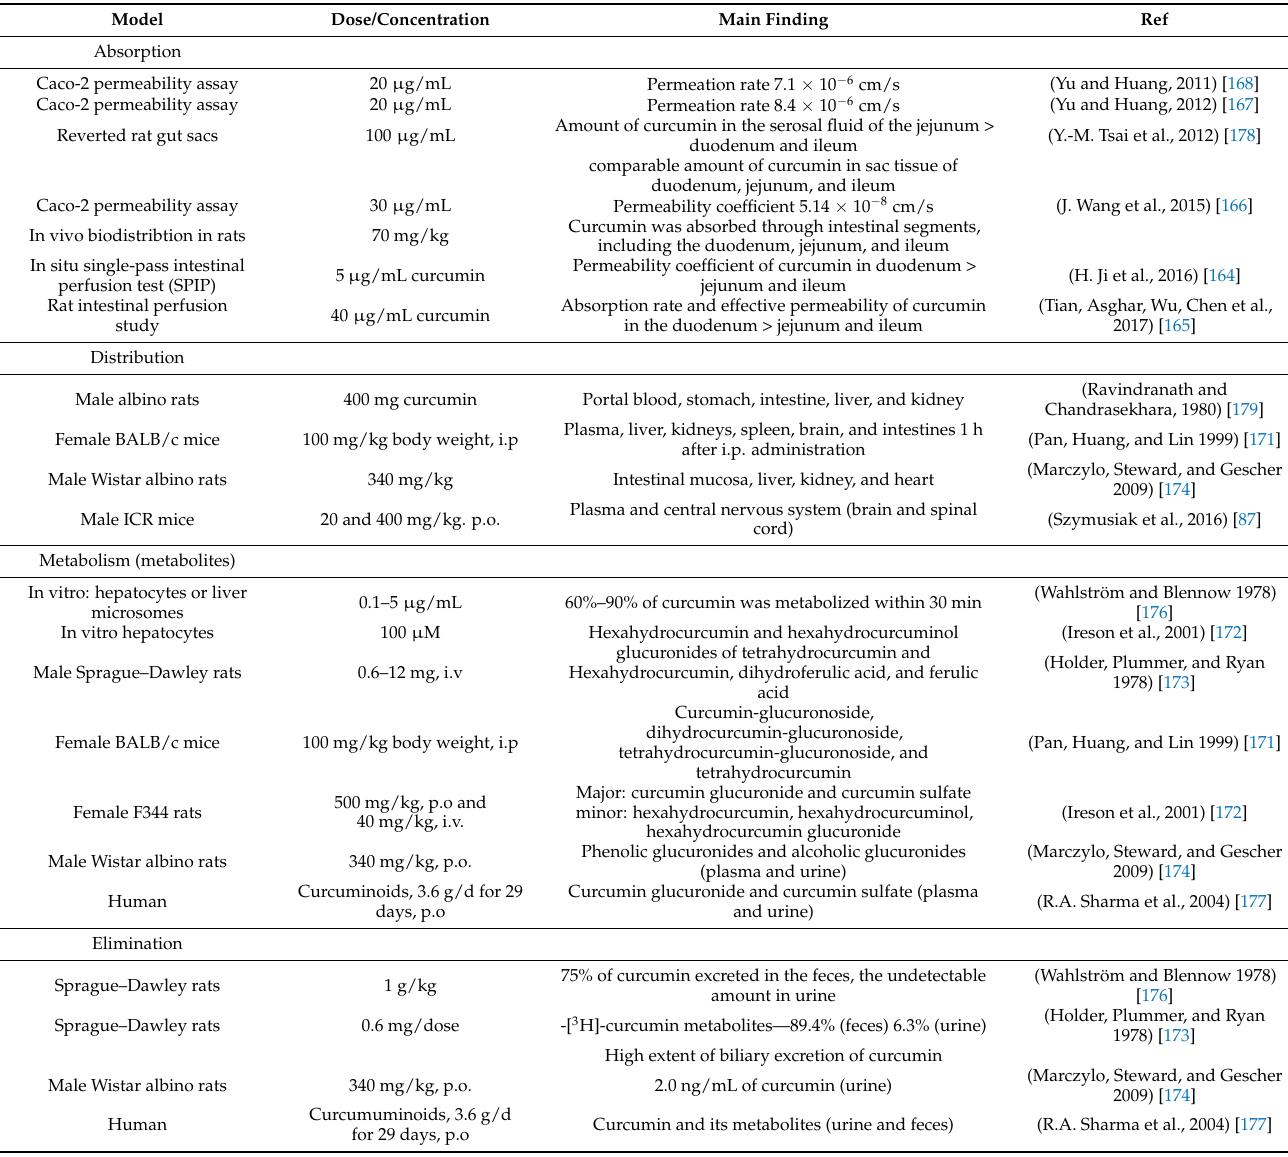
Table 4. Summary of absorption, distribution, metabolism, and elimination of